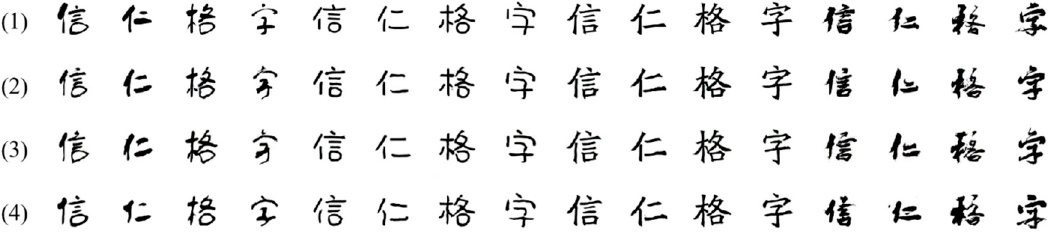
Figure 9. The comparison results of fonts generated by various models. The images of the first row are the ground truth, and the second raw are generated by the Zi2Zi model. Images of the third and fourth rows are generated by EG-GAN 1 and the EG-GAN model, respectively.